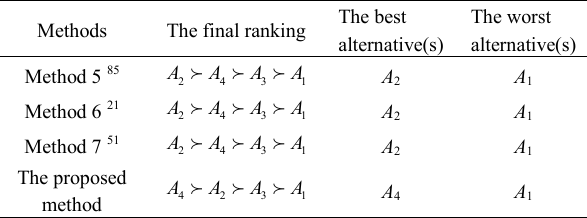
Table 2. The results of different methods using